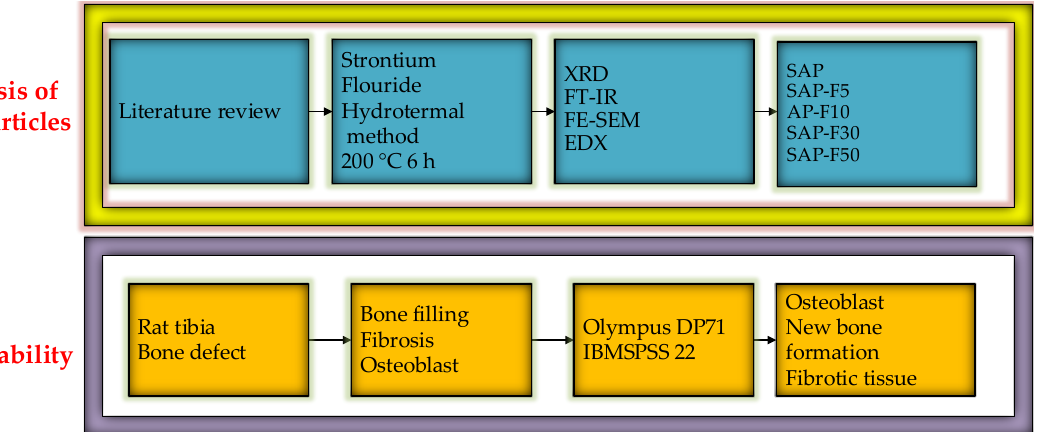
Figure 1. Methodology of research.